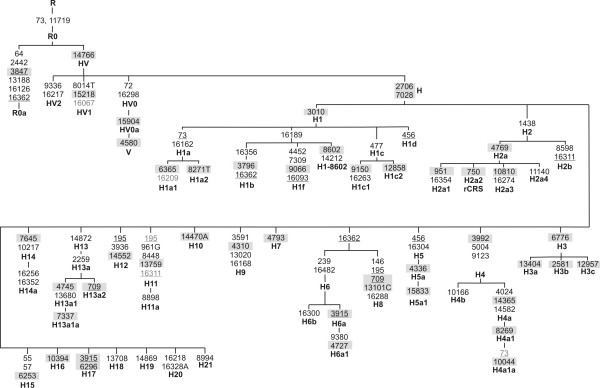
Backbone of the phylogenetic tree of R0 subclades. Mutations are transitions unless the base change is explicitly indicated. Deletions are indicated by a "d" following the deleted nucleotides. Underlining indicates recurrent mutations, whereas mutations in grey were added when observed with a high frequency in a certain branch. Mutations in grey boxes can be targeted with the SNP-multiplex published in [12].